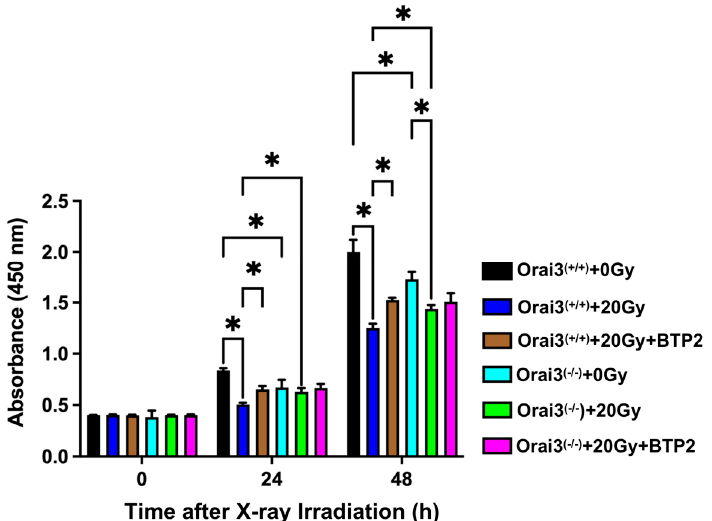
Figure 3. Role of Orai3 in X-ray irradiation-induced inhibition in the proliferation of rat brain microvascular endothelial cells (rBMECs). Summary data showing rBMEC proliferation as assessed using CCK8 assays 0 h, 24 h, and 48 h after rBMECs derived from wild-type rats (Orai3 (+/+) ) that were unexposed (0 Gy) or exposed (20 Gy) to X-ray irradiation and untreated or treated with BTP2 (5 µM); and rBMEC proliferation after cells from Orai3 knockout rats (Orai3 ( − / − ) ) were unexposed (0 Gy) or exposed to X ‒ ray irradiation (20 Gy) and treated or untreated with BTP2 (5 µM). Data are shown as the mean ± SEM ( n = 3), * p < 0.05 analyzed by two-way analysis of variance followed by Dunnett’s multiple comparisons test.